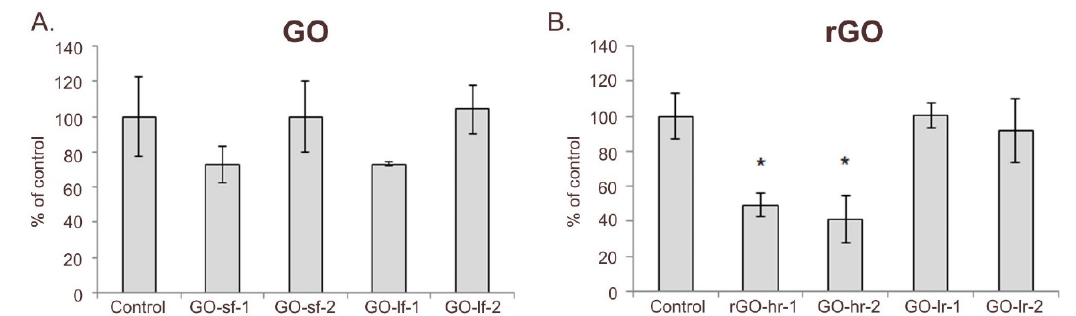
Figure 5. Proliferation of hUC-MSCs after 72 h of cell culture on GO ( A ) and rGO ( B ) substrates. Legend: GO-sf-1: small flakes / thick layer; GO-sf-2: small flakes / thin layer; GO-lf-1: large flakes / thick layer; GO-lf-2: large flakes / thin layer; rGO-hr-1: high reduction level / thin layer; rGO-hr-2: high reduction level / thick layer; rGO-lr-1: low reduction level / thin layer; rGO-lr-2: low reduction level / thick layer; Control: tissue culture plastic surface (TCPS). P values less than 0.05 ( p < 0.05) were considered statistically significant and labeled by an asterisk (*).